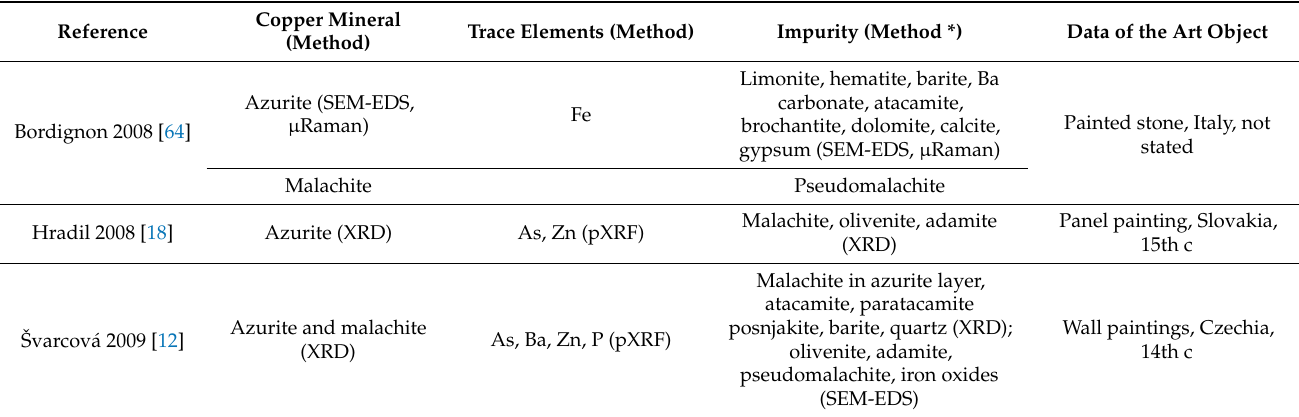
Table 5. Impurities of copper-based paint layers reported in the